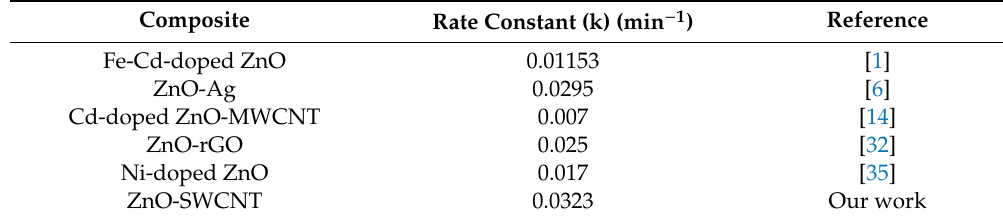
Table 2. Comparison of photocatalytic performance in terms of rate constants.